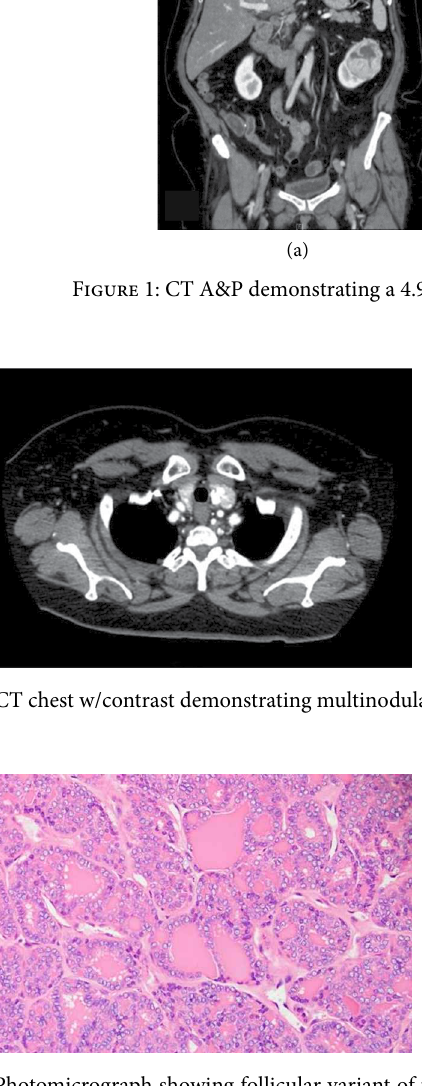
Figure 3: Photomicrograph showing follicular variant of papillary thyroid carcinoma (H&E stain,